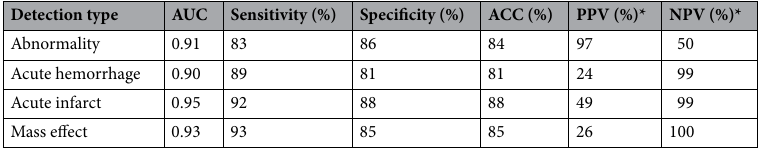
Table 2. Performances of the classifiers on the internal test set. *Note that positive predictive value (PPV) and negative predictive value (NPV) are highly dependent on the prevalence of the finding in a given population.